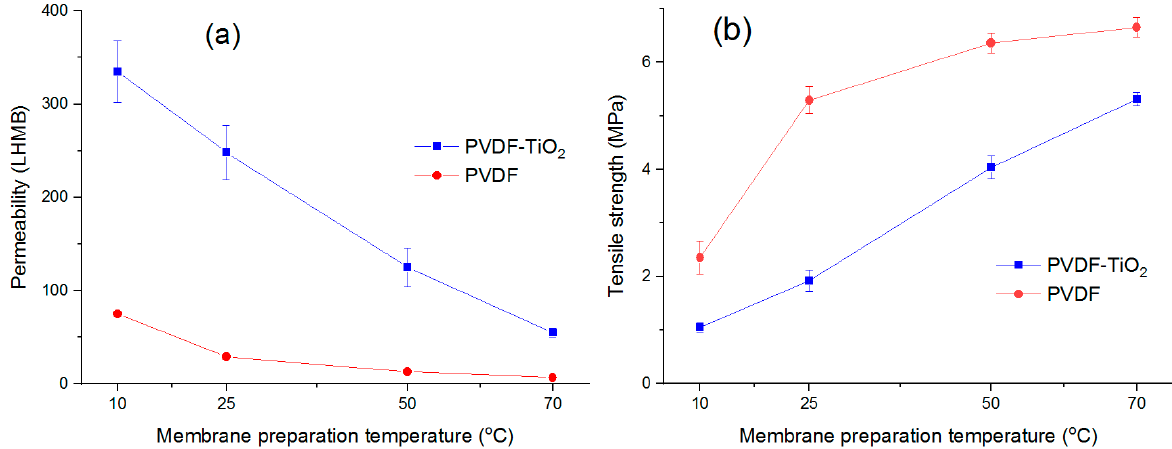
Figure 10. Membrane ( a ) permeability at 20 °C and ( b ) tensile